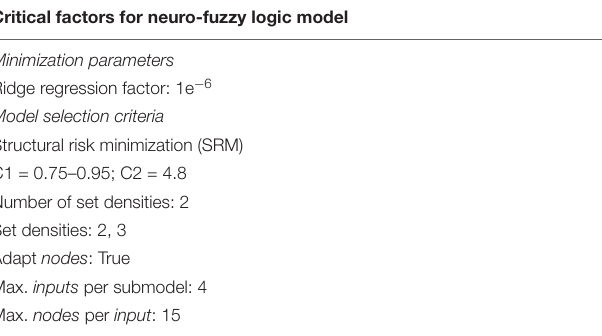
6. Leaf necrosis (LN): number of necrotic leaves per total 7. Curled leaf (CL): number of curled leaves per